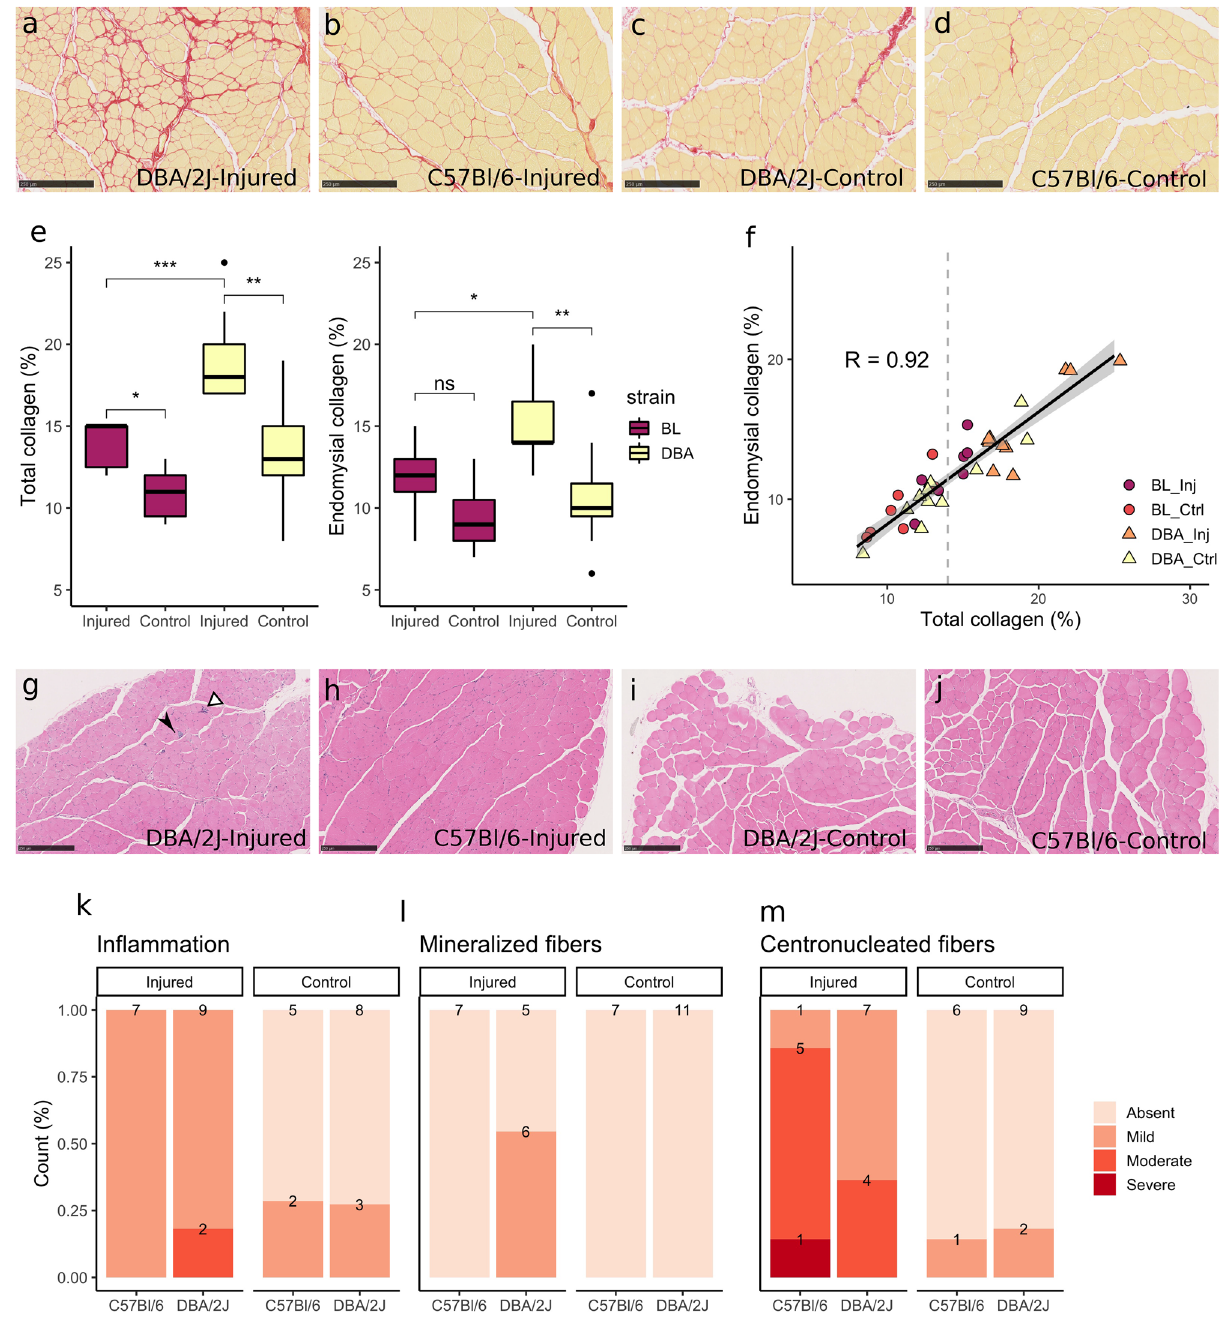
Figure 2. Injury induced fibrosis in non-dystrophic muscles. ( a – d ) Sirius red collagen staining of ( a ) DBA/2J injured muscle, showing marked fibrosis in red; ( b ) C57BL/6 injured muscle, with a moderate increase in collagen staining; ( c ) DBA/2J and ( d ) C57BL/6 non-injured control muscles, showing thin connective tissue layers characteristics of normal skeletal muscles. ( e ) Boxplots show increased total and endomysial collagen fraction in injured muscles, especially in DBA/2J mice. ( f ) Total and endomysial collagen fractions were highly correlated (R = 0.92). The majority of non-injured samples presented total collagen fraction below 14%, while the injured muscles presented collagen fraction higher than 14% in general. ( g – j ) Haematoxylin–eosin staining of ( g ) DBA/2J injured muscle, with moderate inflammation (white arrowhead) and presence of mineralized fibers (black arrowhead); ( h ) C57BL/6 injured muscle, showing high count of centronucleated fibers but no inflammation; ( i ) DBA/2J and ( j ) C57BL/6 non-injured control muscles. ( k – m ) Increased collagen fraction occurred simultaneously with mild inflammation ( k ), low count of necrotic mineralized fibers in DBA/2J mice ( l ) and regeneration, reflected by the presence of centronucleated fibers ( m ). ( a ), ( c ): magnification × 10, scale bar 250 μm. *p < 0.05, **p < 0.01, ***p < 0.001, ns